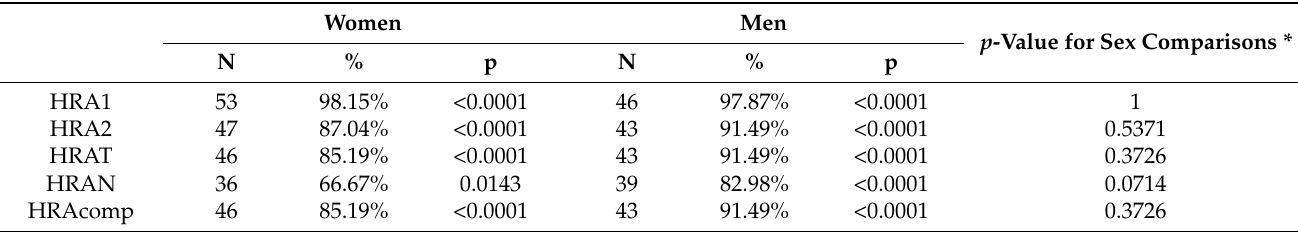
Table 4. The prevalence of short-term, long-term, total HRA, and HRA compensation in all studied men (n = 47) and women (n = 54) from 48-h ECG recordings of carefully selected healthy individuals.